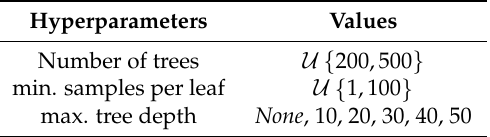
Table 2. List of the hyperparameters and their possible values used in the randomized search. U { a , b } is the discrete uniform distribution between a and b . When the maximum tree depth is set to None , the nodes are expanded until all leaves are